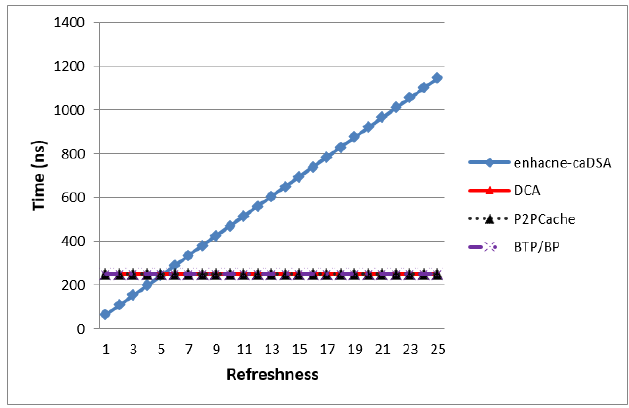
Figure 21. Time of cache management.